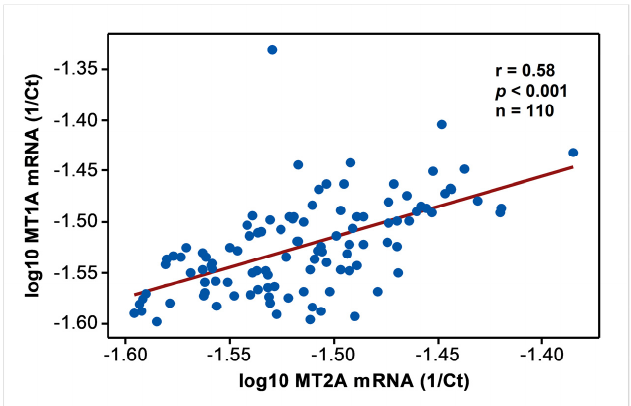
Figure 2. MT2A mRNA expression follows hMT inducer; Cr in individuals with good renal outcomes in CKDu endemic Padaviya area. Data were tested for Pearson’s correlation and plotted in linear scale axes.